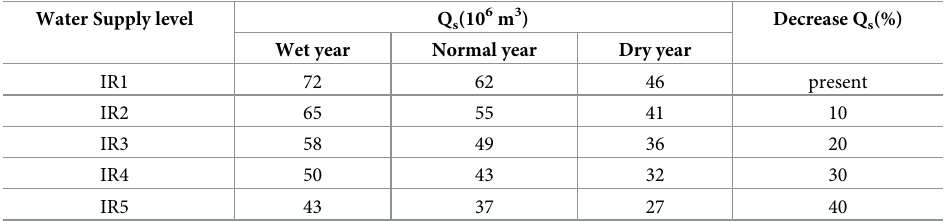
Table 2. Maximum of total available canal water amount quota (the decrease in percentage of each water supply level was calculated in comparison to